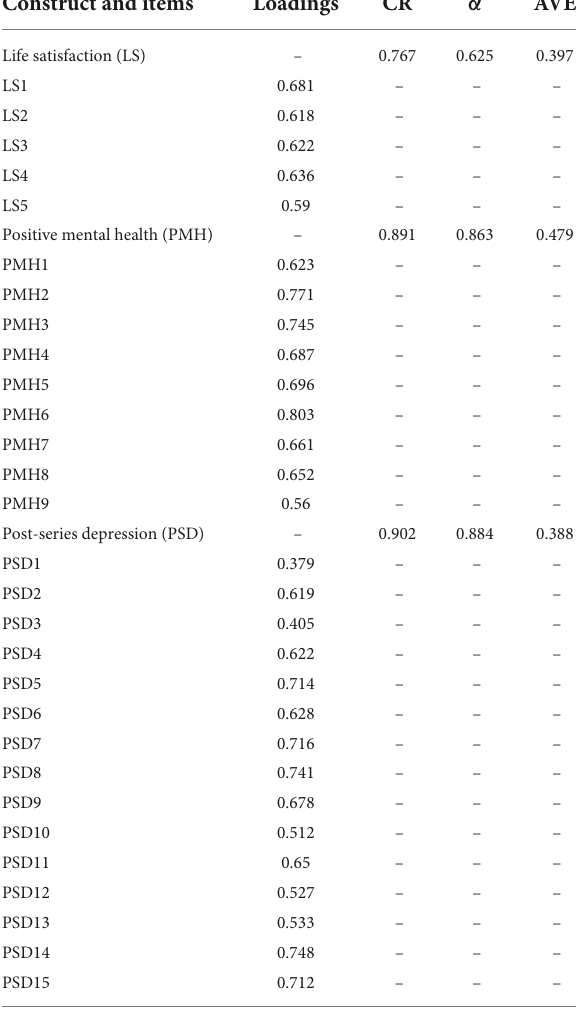
TABLE 2 Results of the reflective measurement